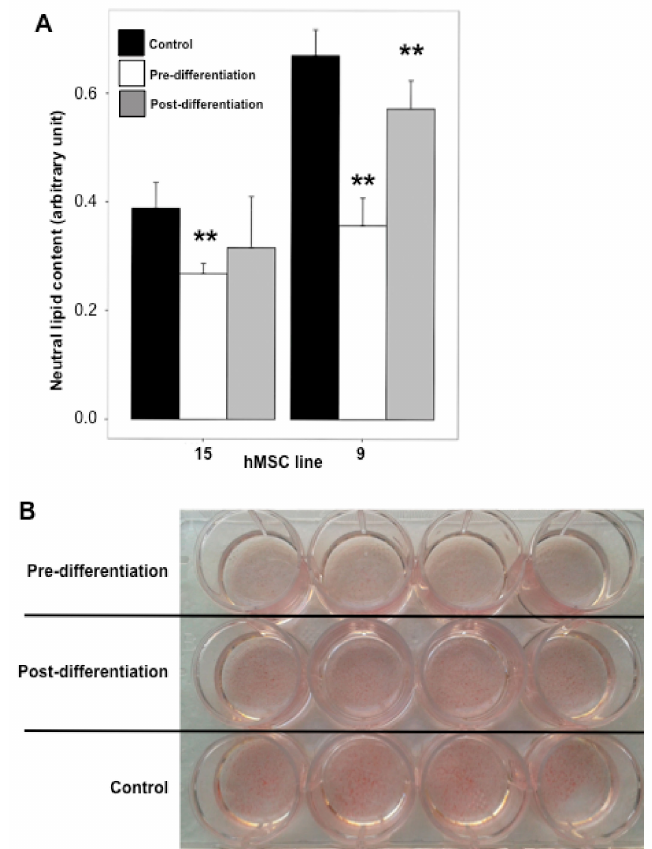
Figure 4. Influence of piceatannol on lipid accumulation during the early and late phase of in vitro adipogenesis. ( A ) Neutral lipid content in control (black column) or hMSC treated by medium supplemented with 50 µ M piceatannol before (pre-differentiation, white column) of after induction of adipogenesis (post-differentiation, shaded column). Each column is the mean ± SEM of quadruplicates for the indicated hMSC lines. ** p < 0.01 for the differences between the control and the pre- and post-differentiation treatments by one-way ANOVA and Dunnett’s post-hoc test. ( B ) Picture of a multi-well culture plate with lipid staining of the line hMSC 9 after control and pre- and post-differentiation treatment with 50 µ M